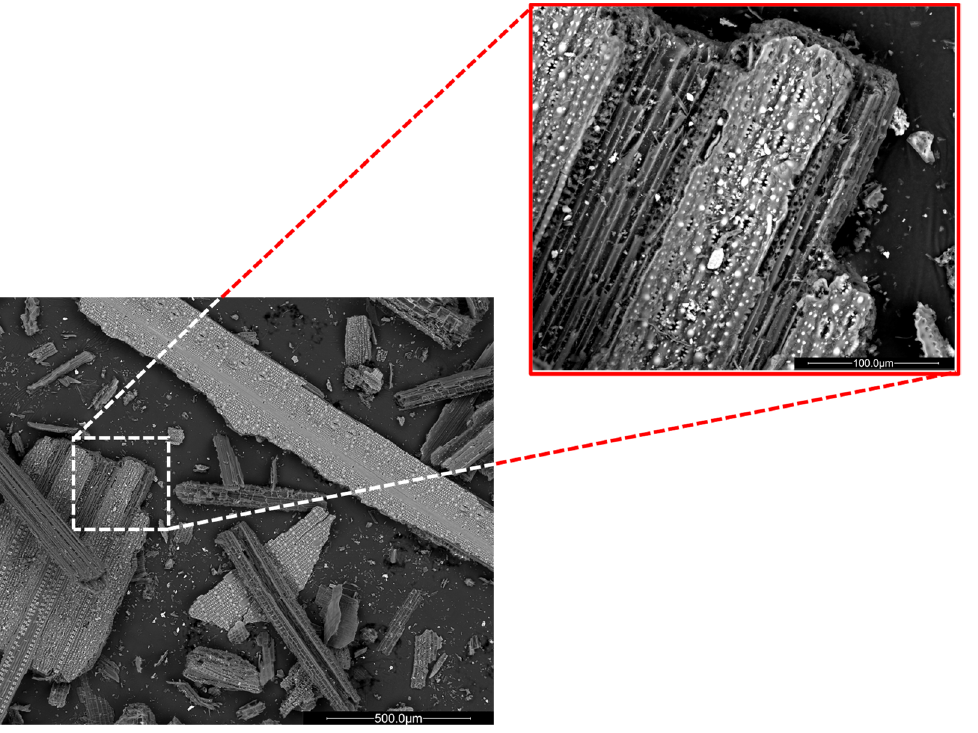
Figure 4. The SEM inspection for wheat straw sample at 500 µm and larger magnification at 100 µm.